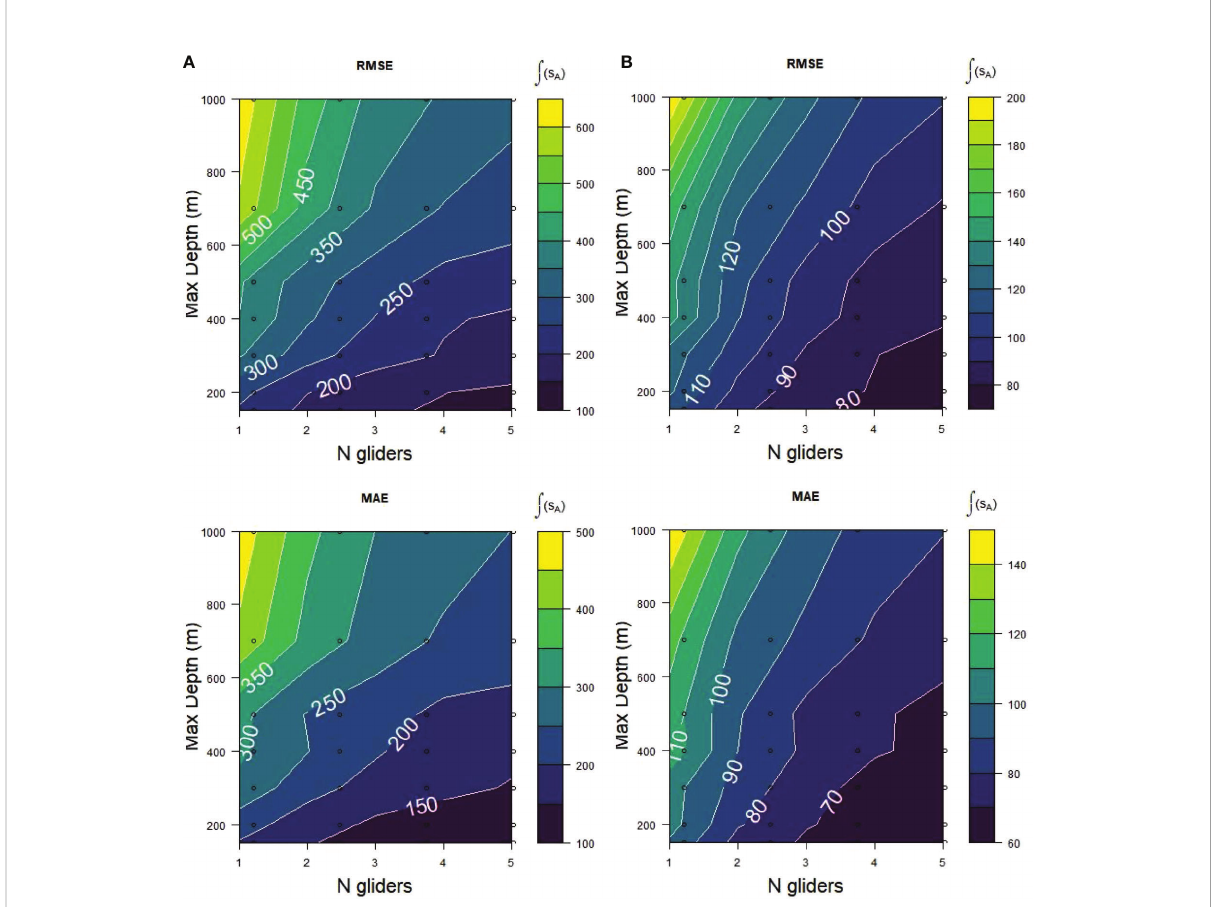
FIGURE 7 RMSE and MAE scores for acoustic samples (s A ) from (A) Brans fi eld Strait and (B) Cape Shirreff obtained at 7 maximum dive depths from 150 to 1000 m with 1 to 5 simulated gliders during 2001 to 2011. Each plot represents mean scores of 500 replicates during 10 years. Lower scores (darker colors) represent better fi ts of the glider sampling to the sample